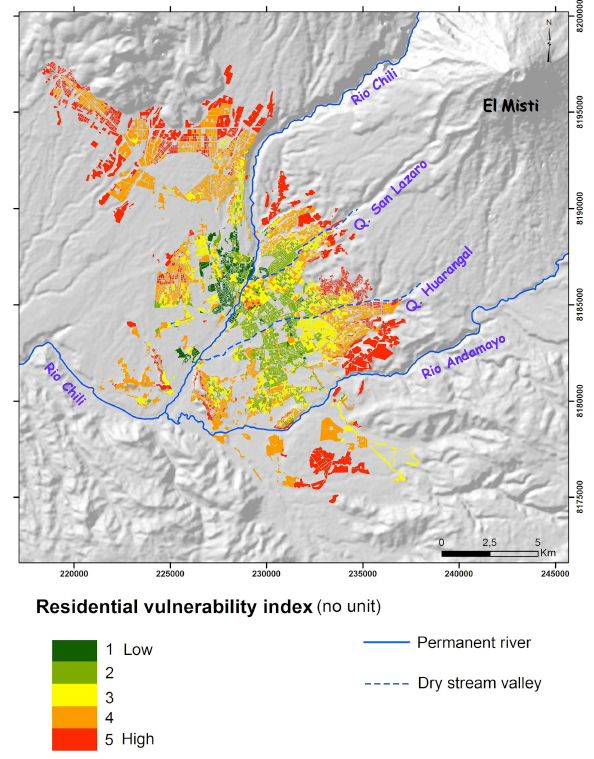
Fig. 8. Map of the residential vulnerability in Arequipa. The res- idential vulnerability index (RvI) comprises five classes (see Ta- ble 4). The scale of original data (city block) ensures a high level of precision. Using this general map, one can focus on specific areas without any additional